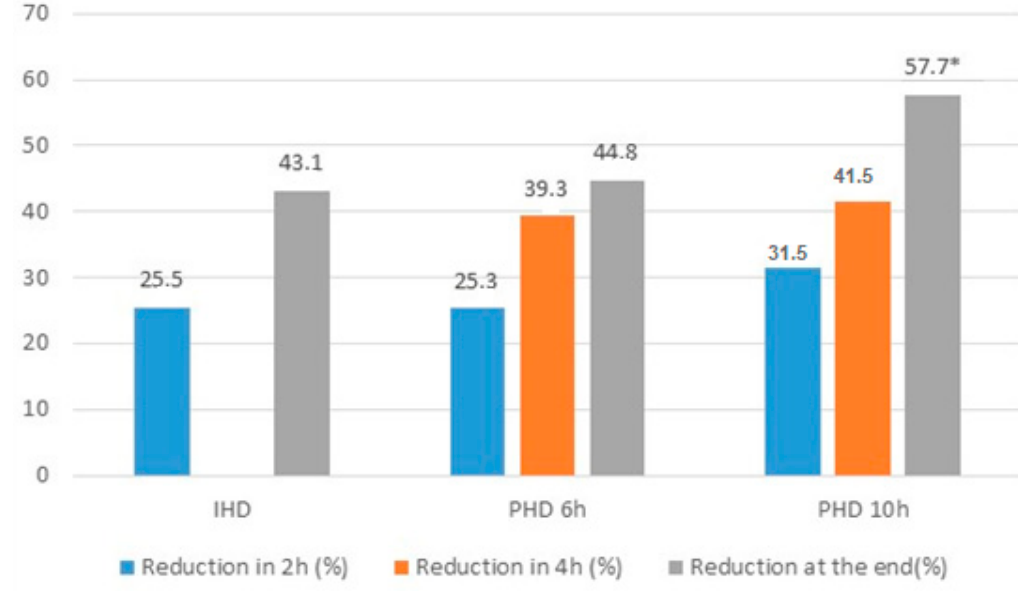
Figure 2. Reduction of vancomycin in 2 h, 4 h and at the end of dialysis in the groups HDI, HDP 6 h and HDP 10 h. * p < 0.05 PHD 10 h vs. IHD, p < 0.05. Table 5. General characteristics of the population according to the area under the curve / minimum inhibitory concentration of